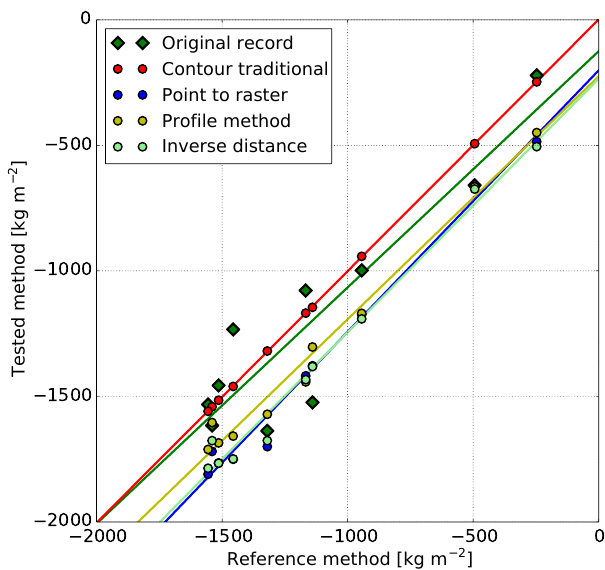
Figure 9. Annual mass balances as obtained from the different extrapolation methods plotted against the results of the reference method. Basic statistics related to this plot are shown in Table